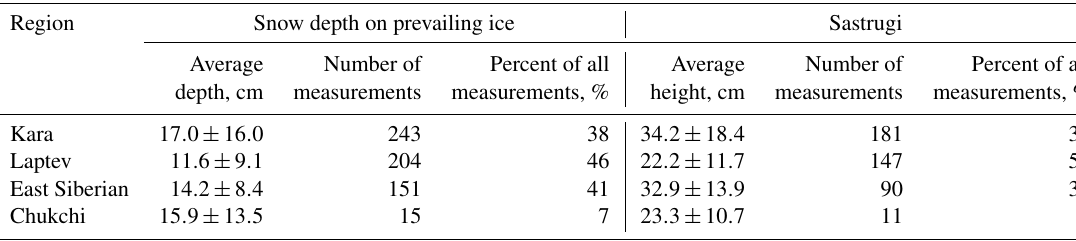
Table 5. Average snow depth on the level ice and height of sastrugi in the fast ice area. Region Snow depth on prevailing ice Sastrugi Average Number of Percent of all Average Number of Percent of all depth, cm measurements measurements, % height, cm measurements measurements, % Kara 17 . 0 ± 16 . 0 243 38 34 . 2 ± 18 . 4 181 39 Laptev 11 . 6 ± 9 . 1 204 46 East Siberian